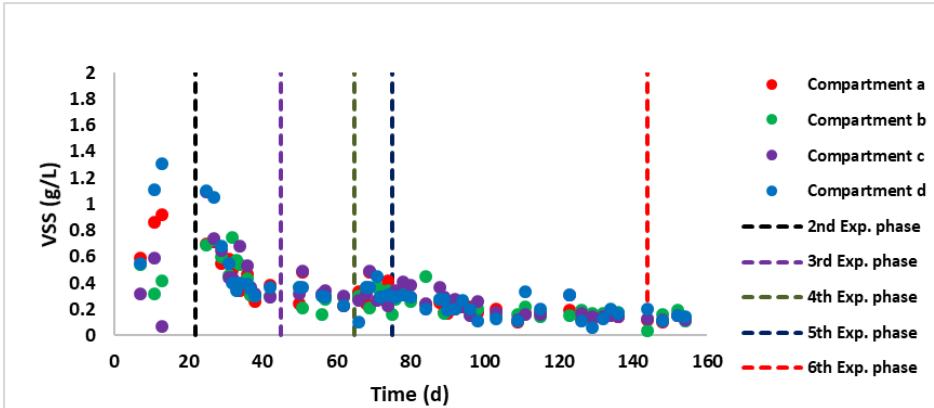
Figure 9 . Daily TSS concentration in reactor compartments. Figure 10 . Daily VSS concentration in reactor compartments. Figure 10. Daily VSS concentration in reactor